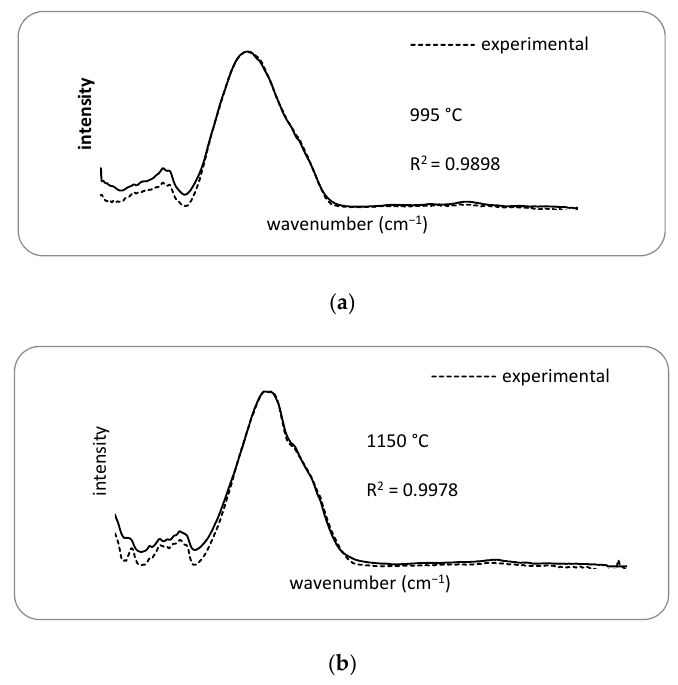
Figure 3. FTIR experimental spectra for fired sample bodies and their calculated FTIR spectra. Temperatures: 995 °C ( a ) and 1150 °C ( b ).